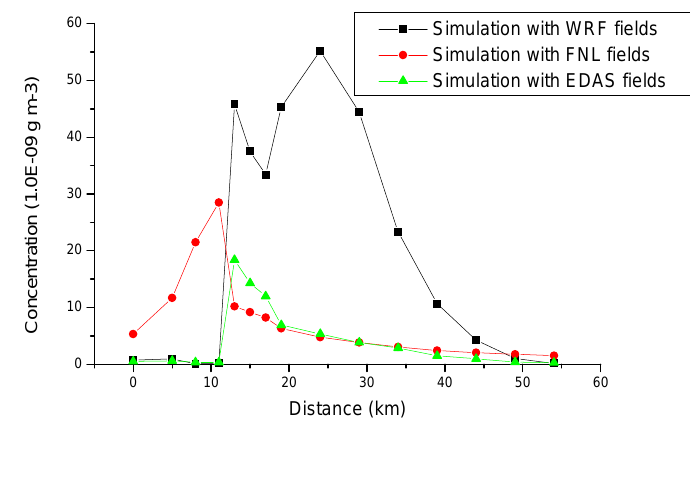
Figure 11. Simulated downwind concentration of SO at 02-04 UTC 02 June,